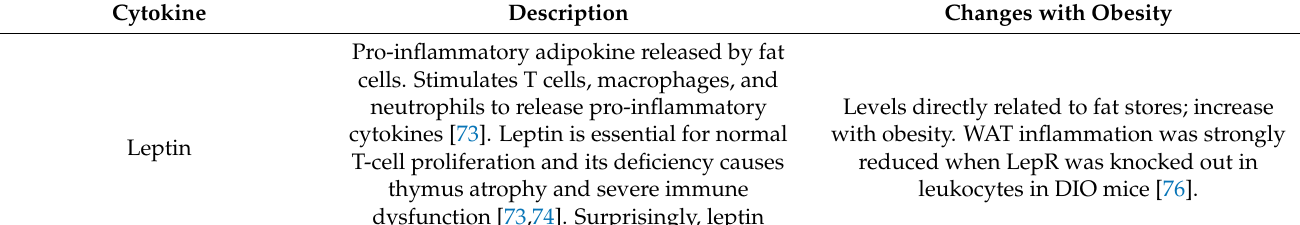
Table 1. Obesity-induced cytokine